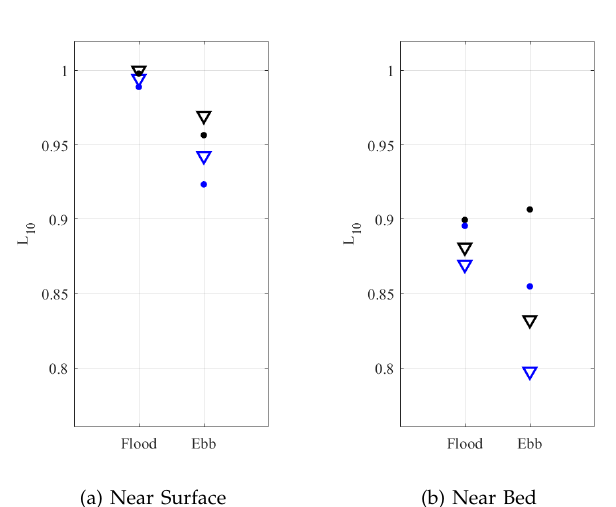
Fig. 6. Normalised damage equivalent loads for one velocity bin (2.2-2.4 m/s) determined using varying (open triangle) and mean (solid dot) measured profiles (black) and predicted profiles